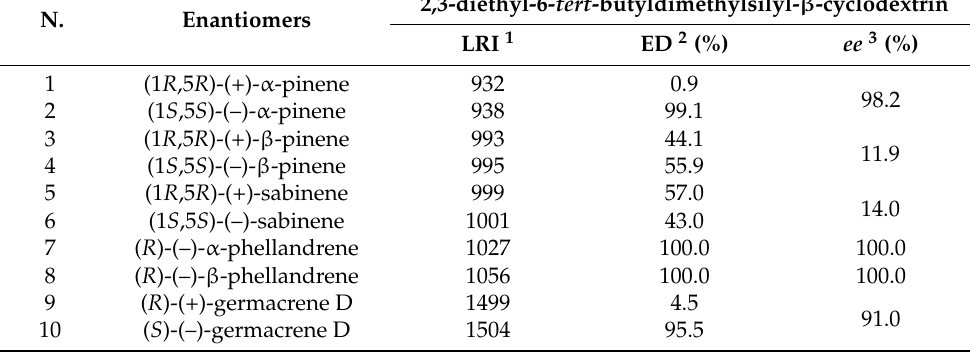
Table 2. Enantioselective analysis of G. miniphylla EO, obtained with a β -cyclodextrin-based capil- lary column.